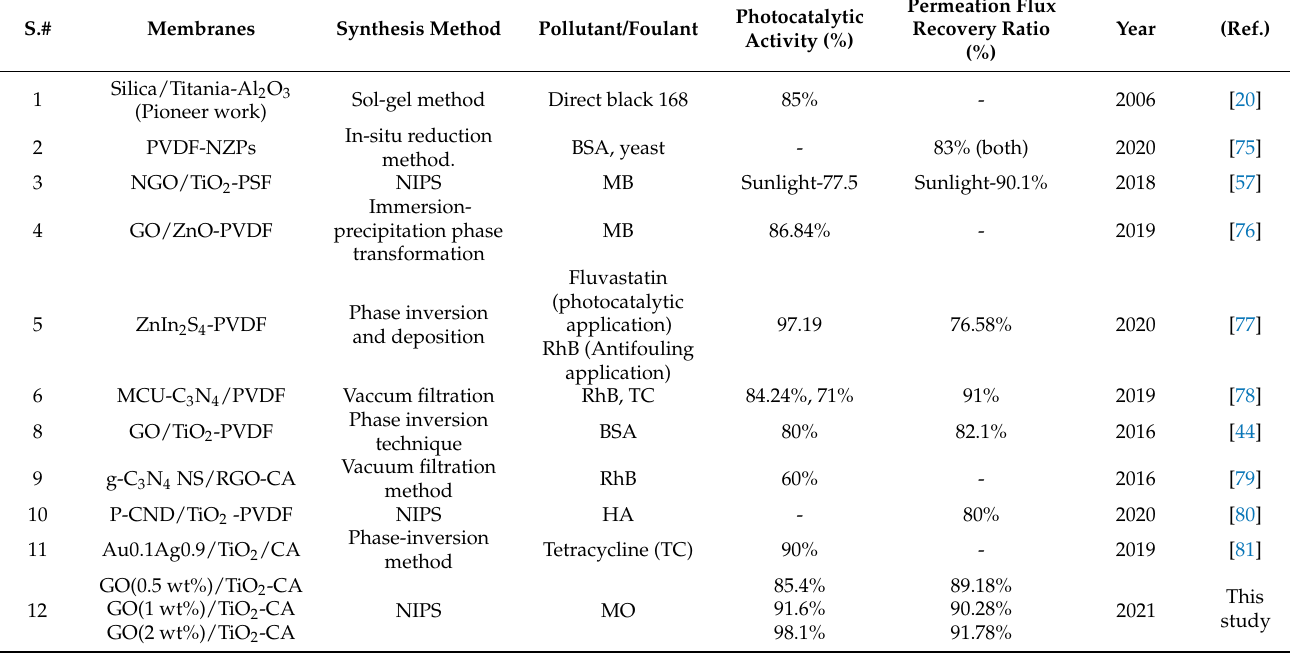
Table 3. Comprehensive comparison of various published nanomaterials incorporated membranes with this study. S.#